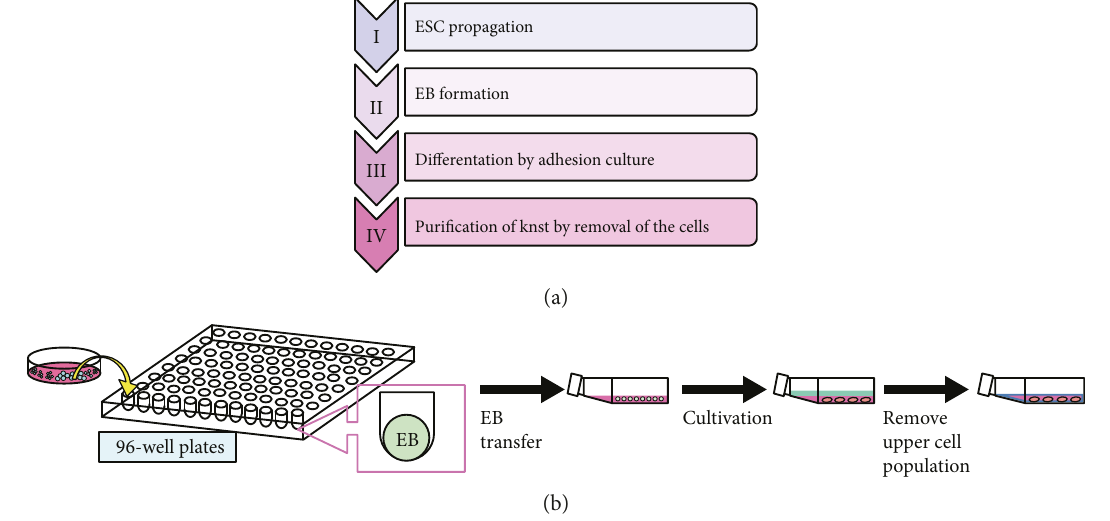
Figure 1: Generation of mesenchymal stromal cells from sees2. (a) Step-by-step manufacturing process. (b) Scheme for generation of mesenchymal stromal cells from